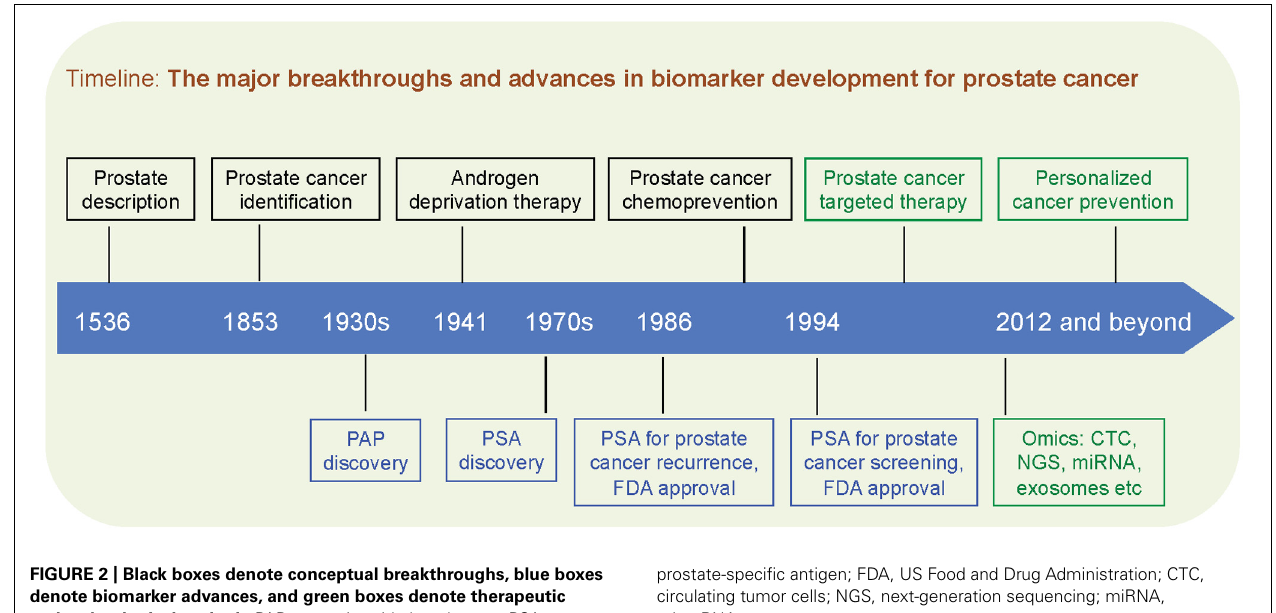
prostate-specific antigen; FDA, US Food and Drug Administration; CTC, circulating tumor cells; NGS, next-generation sequencing; miRNA,